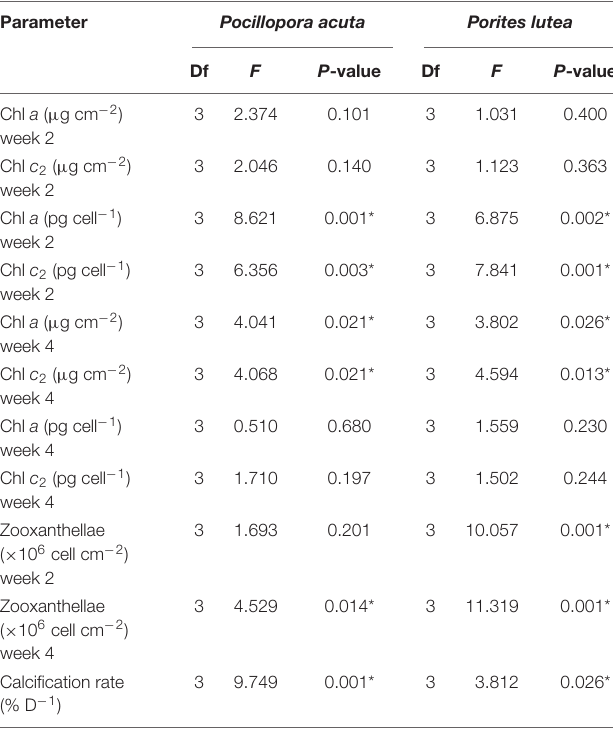
TABLE 3 | Statistical analysis of chlorophyll a and c 2 , zooxanthellae density and calcification rate (One-way ANOVA).